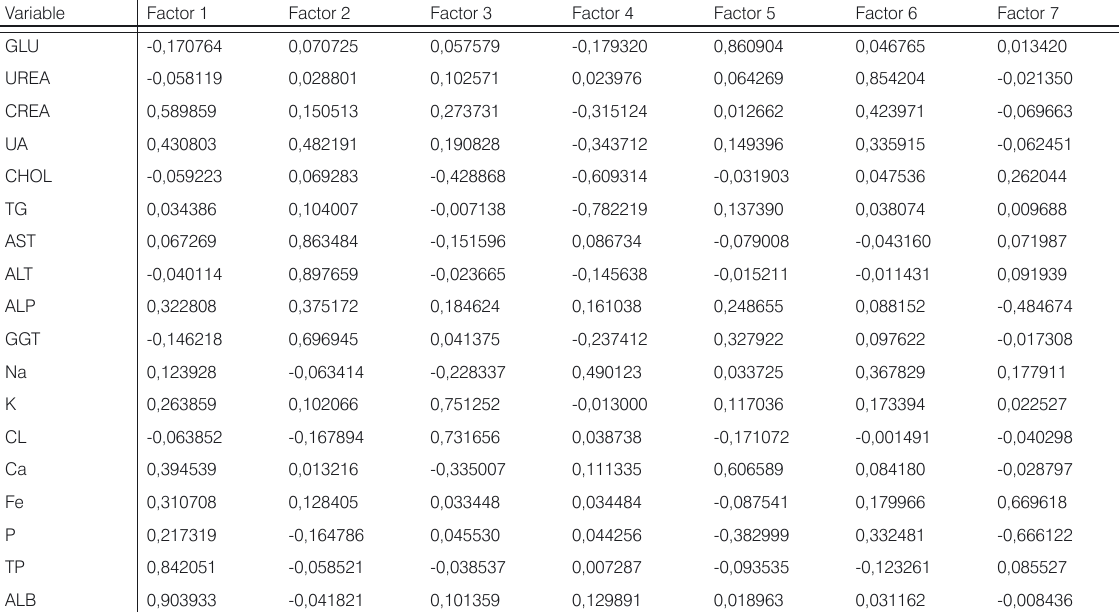
Table 5. Factor loadings of all healthy subjects studied biochemical